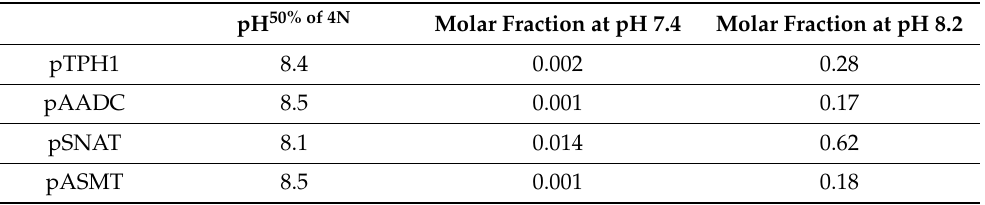
Table 2. Values of pH value at which there is 50% of 4N hydrolytic Ni(II) complex formed and molar fractions of this complex at pH 7.4 and 8.2 for peptides pTPH1, pAADC, pSNAT, and pASMT. pH 50% of